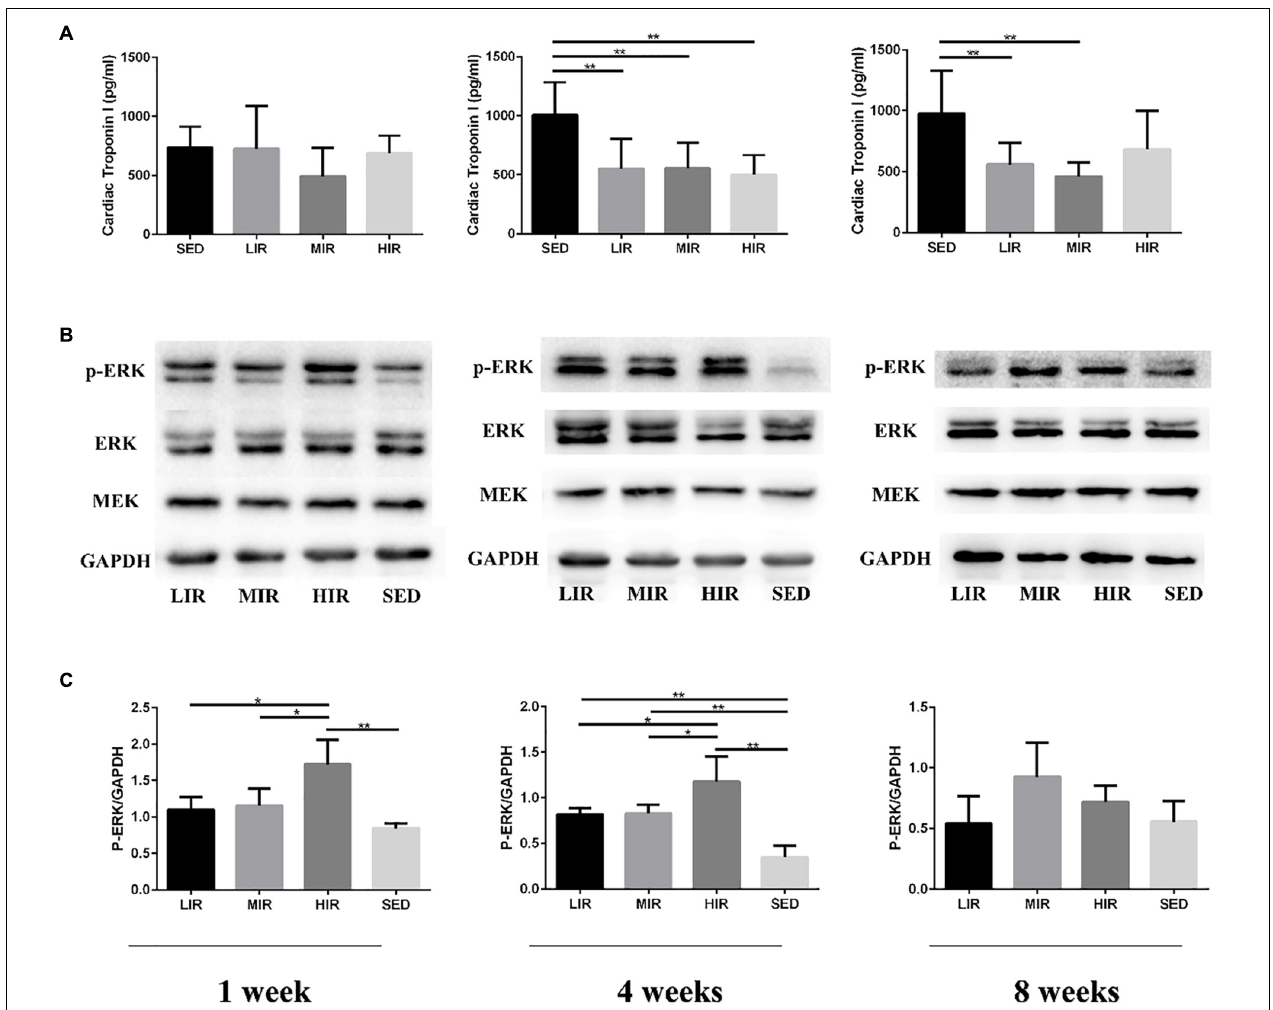
FIGURE 3 | Effects of different treadmill running intensities after 1, 4, and 8 weeks on serum cTnI levels (A) and ERK phosphorylation (B,C) in rats. Data are presented as the means ± SEM. * P < 0.05, ** P <